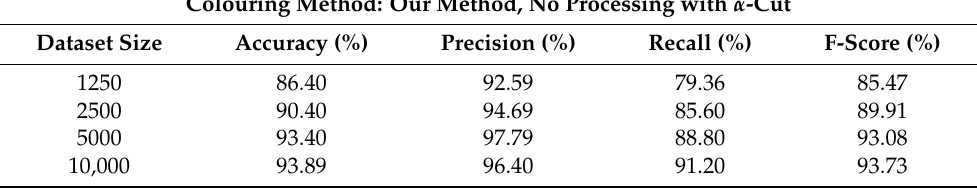
Table 8. Performance metrics for our method, without α -cut processing. Colouring Method: Our Method, No Processing with α